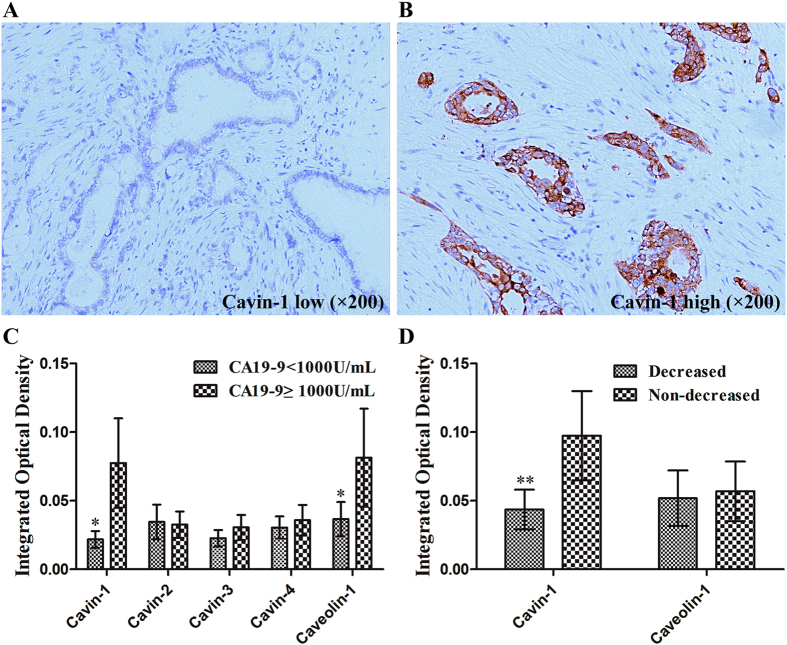
Expression of molecules in the cavins/caveolin-1 axis in pancreatic ductal adenocarcinoma (PDAC).(A,B) Representative images of low and high cavin-1 expression in PDAC tissue. Cavin-1 was mainly located in the cytoplasm of neoplastic cells, and scattered expression was also seen in the nuclei (×200 magnification). (C) The differentially expressed molecules in the cavins/caveolin-1 axis in the training cohort according to the CA19-9 categorization. Compared with patients with CA19-9 < 1,000 U/mL, the levels of cavin-1 and caveolin-1 were significantly higher in patients with CA19-9 ≥ 1,000 U/mL (*P < 0.01), whereas no statistical difference was found for cavin-2, -3, and -4. (D) Differential expression of cavin-1 and caveolin-1 in subgroups of patients with CA19-9 ≥ 1,000 U/mL. The level of cavin-1, rather than caveolin-1, was dramatically higher in patients with CA19-9 that did not decrease postresection, compared with patients whose CA19-9 did decrease postresection (*P = 0.017).